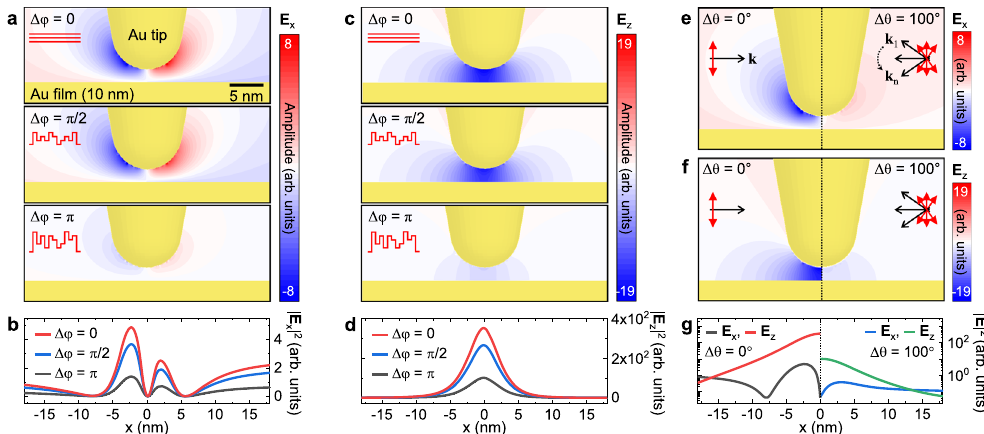
Fig. 2 Finite-difference time domain (FDTD) analysis of wavefront shaping the tip apex fi eld. a , c Simulated in-plane ( E x ) and out-of-plane ( E z ) optical fi eld distribution with respect to the spatial phase variation ( Δ φ , see Methods for details). b , d In-plane ( ∣ E x ∣ 2 ) and out-of-plane ( ∣ E z ∣ 2 ) optical fi eld intensity pro fi les at the horizontal plane 1 nm underneath the tip derived from ( a , c ). e , f Comparison of E x and E z optical fi eld distribution for optimal (left) and conventional (right) excitation polarization conditions by wave-vector variation ( Δ θ , see “ Methods ” for details). g Optical intensity pro fi les at the horizontal plane 1 nm underneath the tip derived from ( e , f ), exhibiting signi fi cantly reduced excitation rate in the conventional experimental